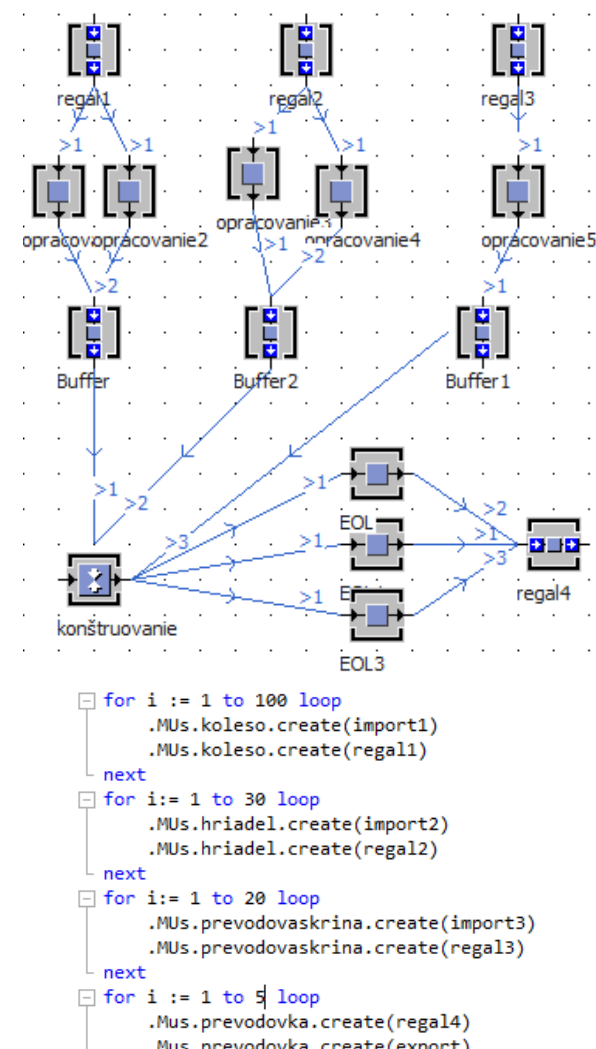
Figure 4: Demonstration of the production process and method of entities